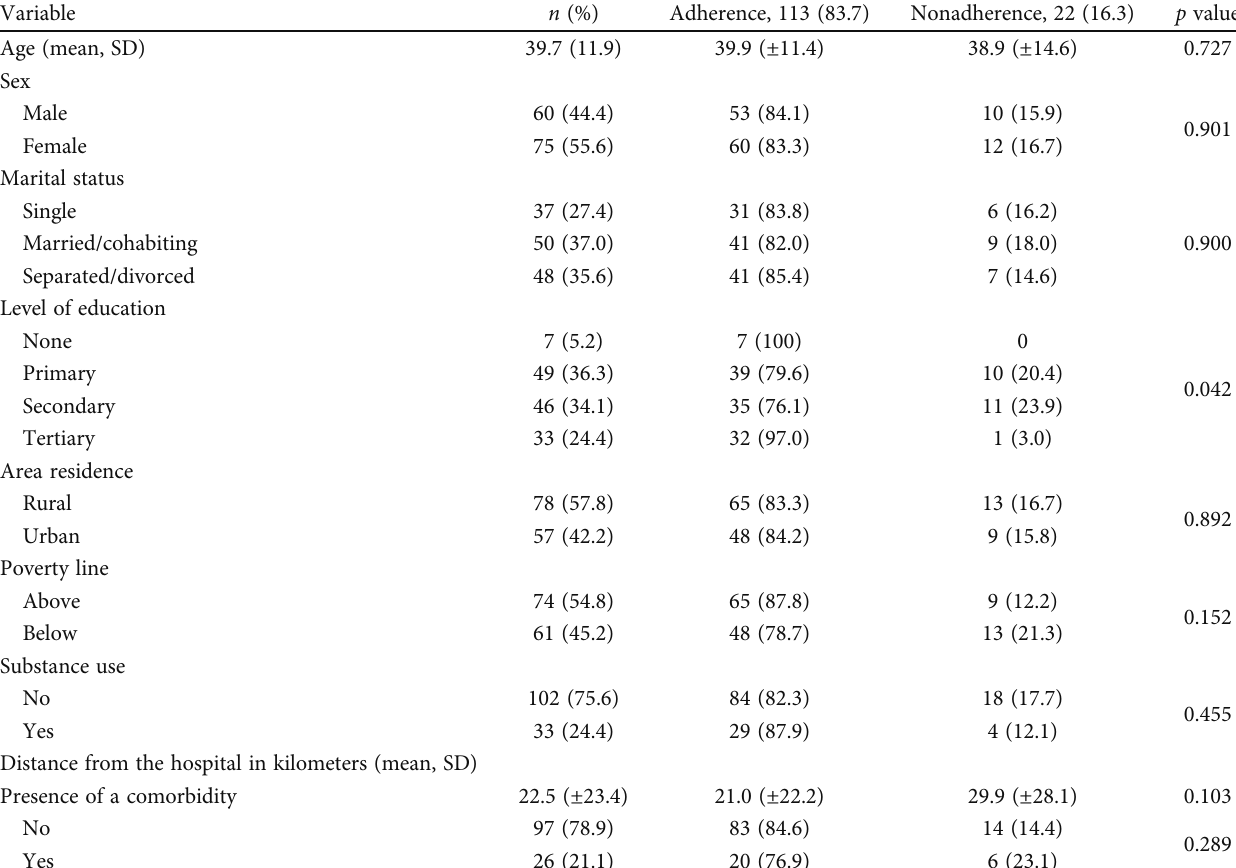
Table 1: Social demographic characteristics of patients with schizophrenia on typical antipsychotics.